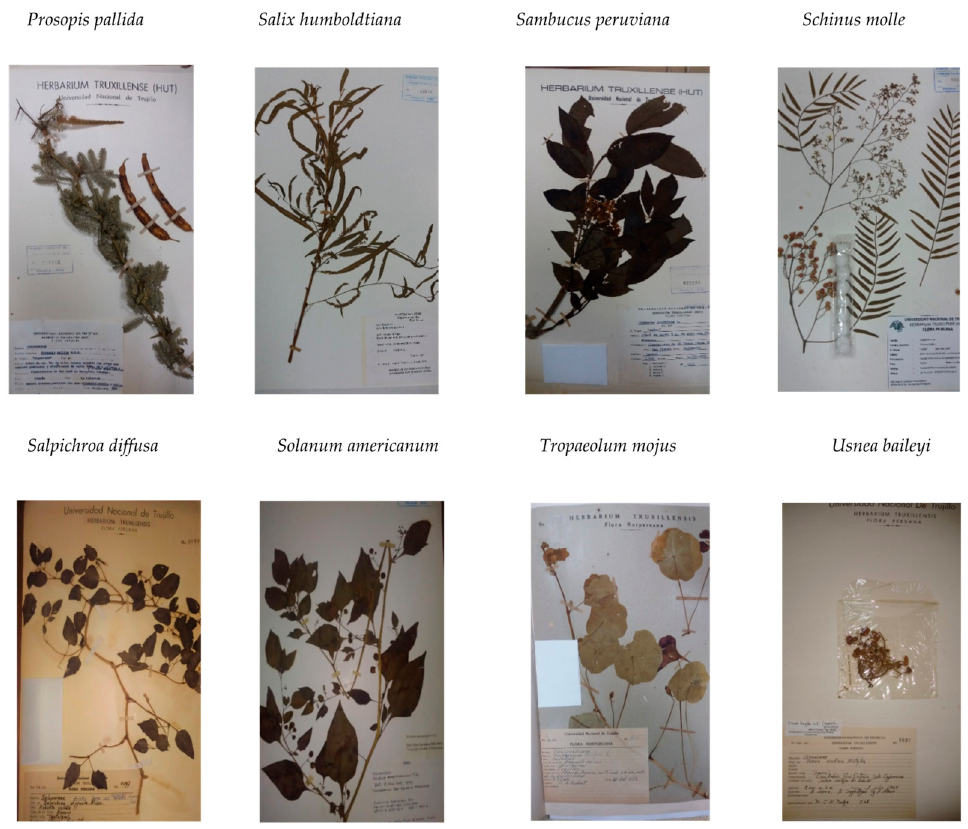
Figure 2. Herbarium specimens of dye plant species registered in the Herbarium Truxillense.